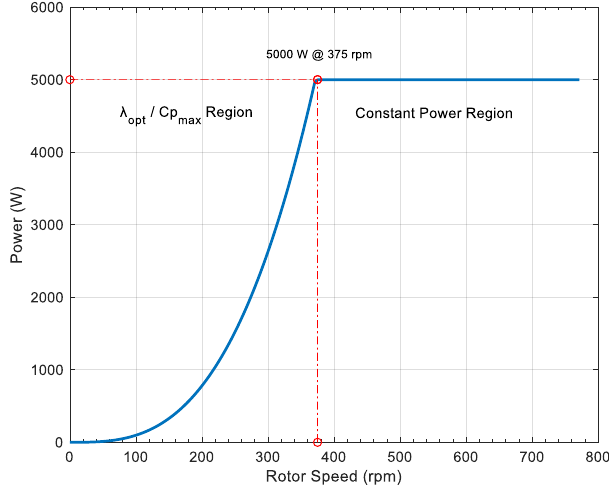
Figure 13. Power-turbine angular speed curve used in the control of the battery charger.